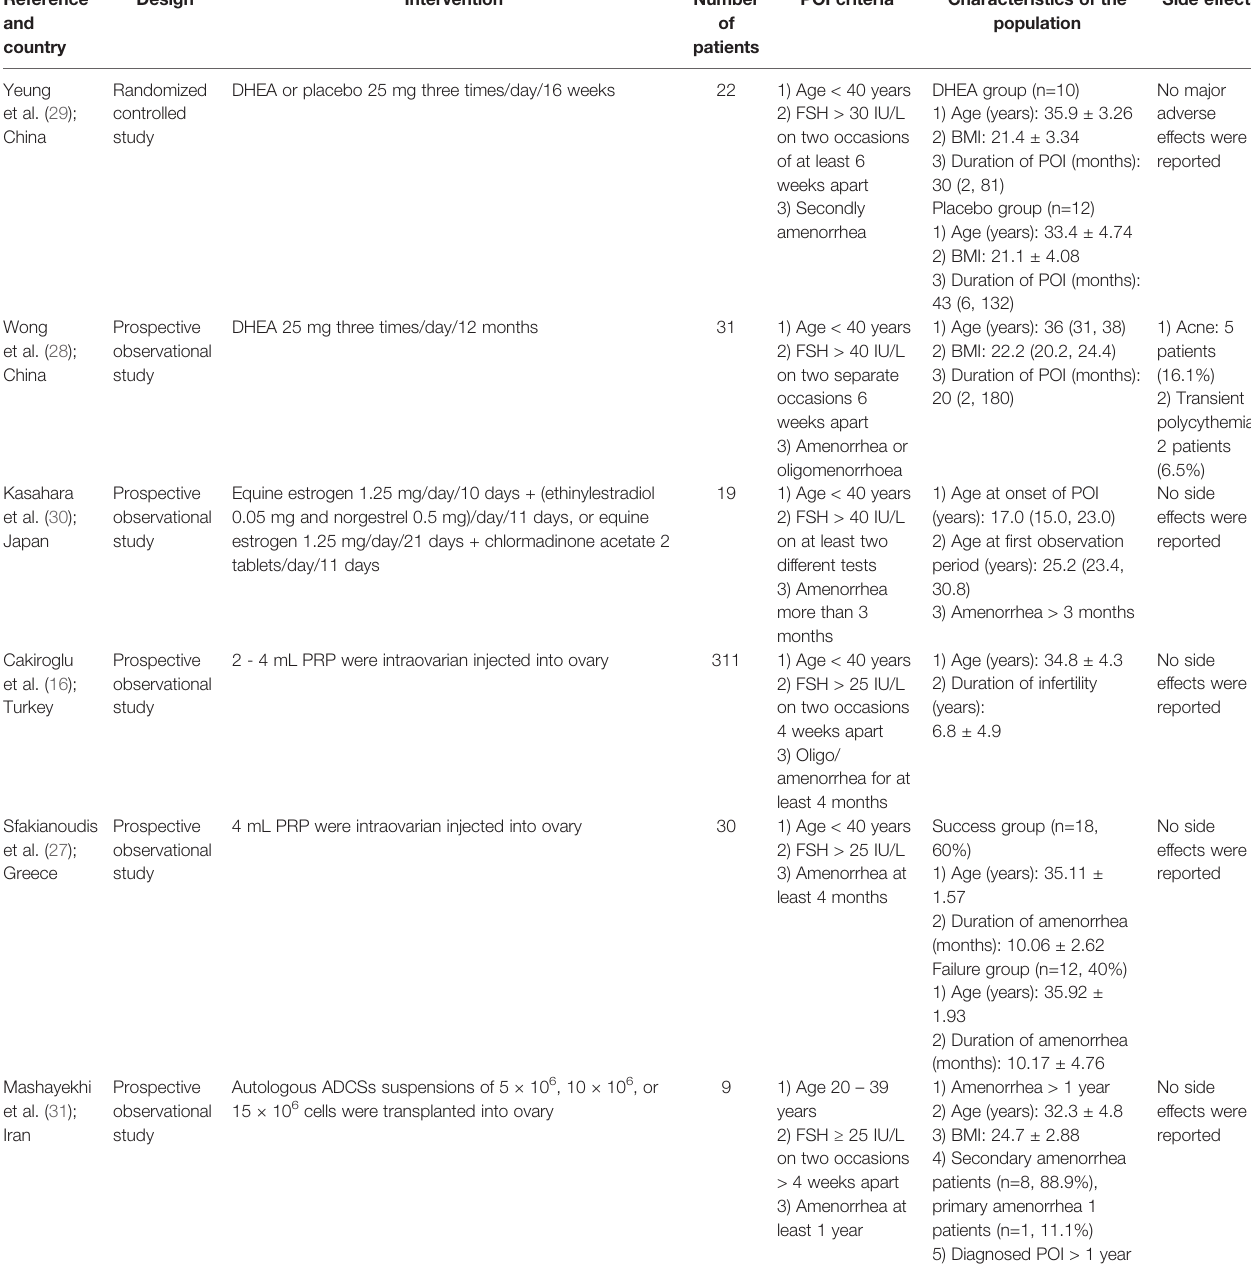
TABLE 1 | Main characteristics of the six studies included in the